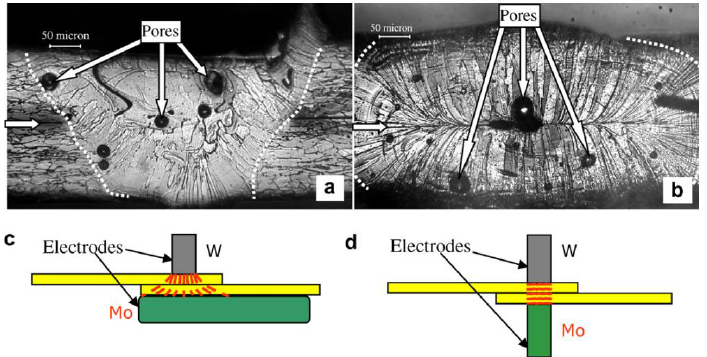
Figure 16. ( a , b ) The shape and microstructure of the nuggets welded using the electrodes shown in ( c , d ), respectively. The horizontal arrows show the interfaces between two workpieces in panels ( a ) and ( b ) [38].